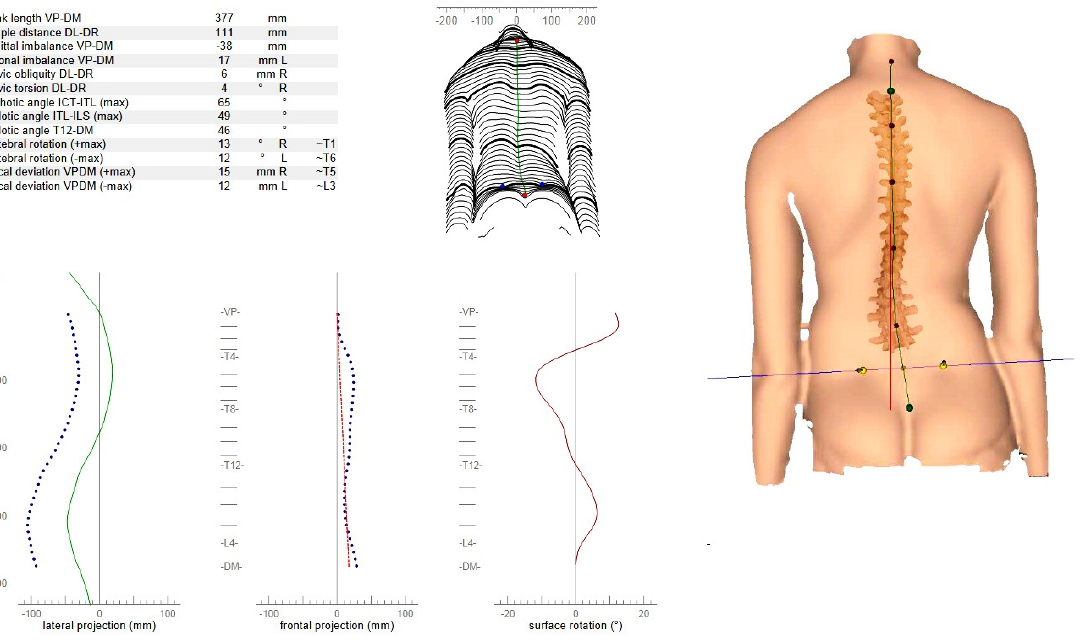
Figure 2. Raster-stereographic assessment of the spine and